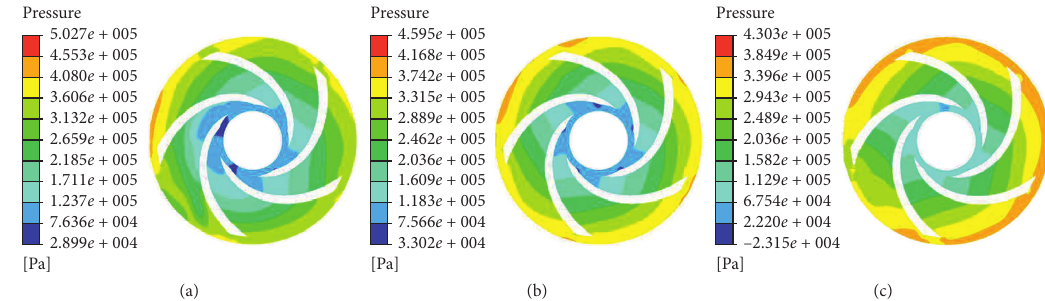
Figure 6: Pressure cloud chart under different working conditions. (a) 0.6Q, (b) Q, and (c) 1.4Q.